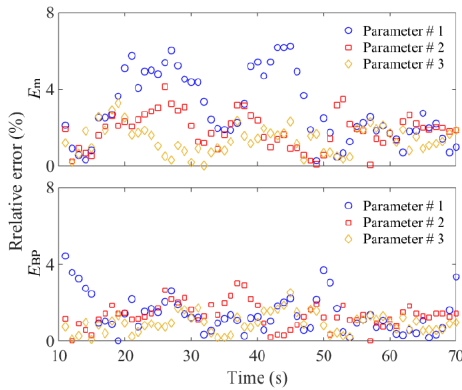
Figure 10. DEM simulation results of relative errors.